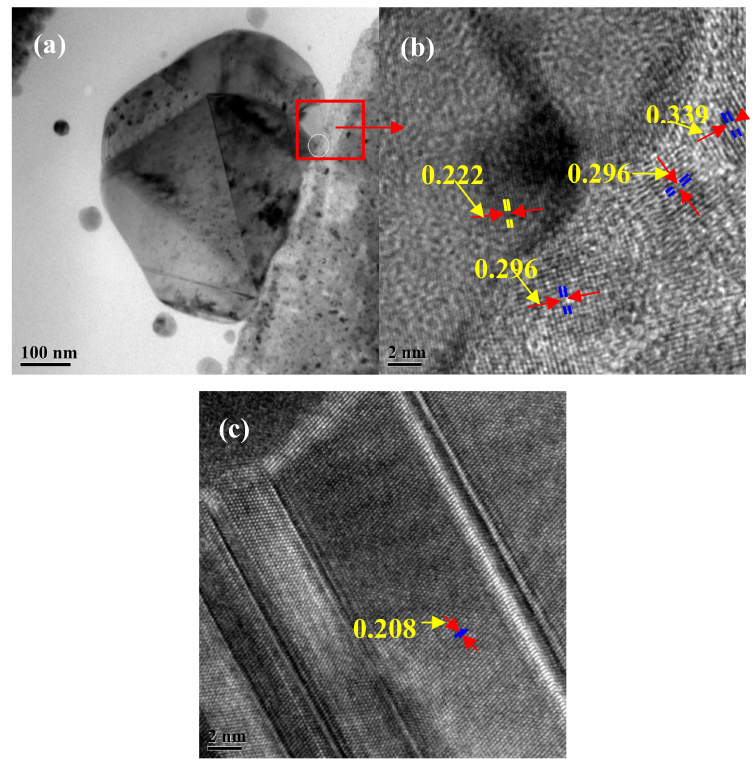
Figure 9. Bright-field TEM images of ( a ) a large Cu particle growth on the surface of the alloy film, ( b ) the high magnification image of ( a ), and ( c ) a normal grain of a pure Cu